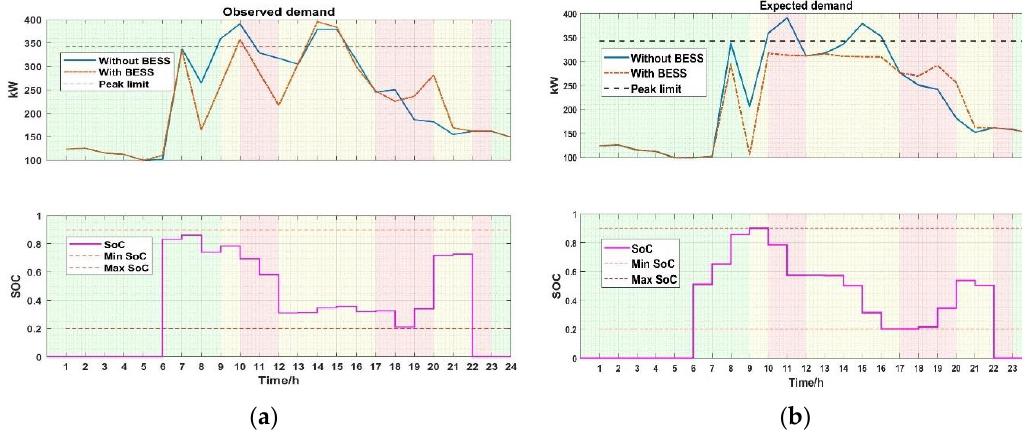
Figure 8. ( a ) PEV schedule using DO base on observed demand ( b ) PEVs’ schedule on observed demand using the proposed approach.